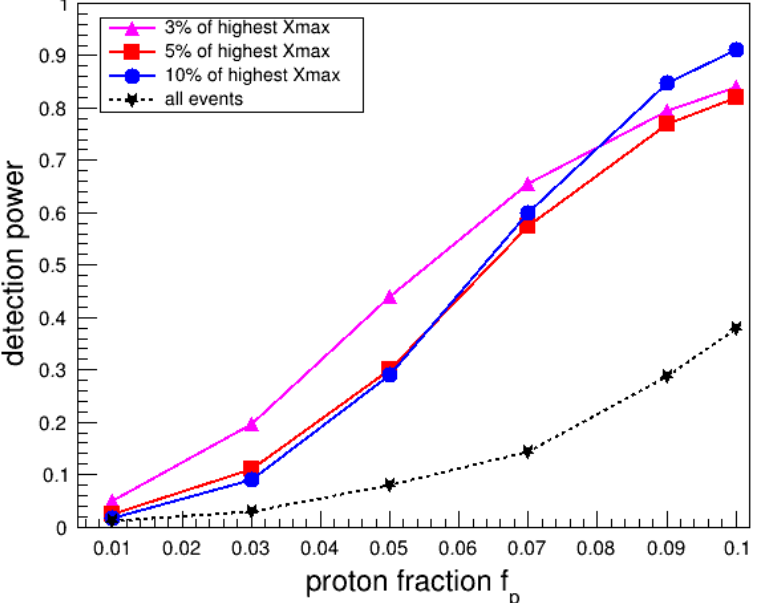
Figure 2. Detection power as a function of the proton fraction f p for different fractions of selected events f sel . The lines indicate the different values of the highest X max X m ax